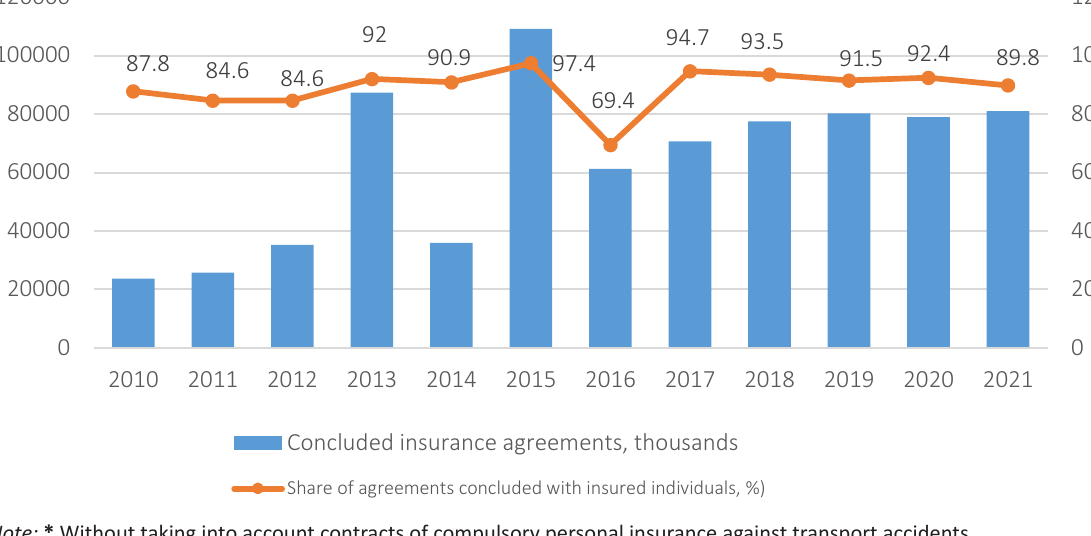
Figure 2. The number of insurance contracts concluded in